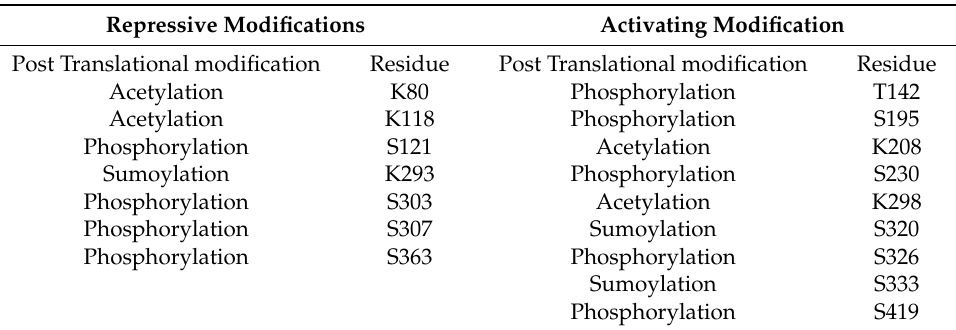
Table 1. Post translational modification of